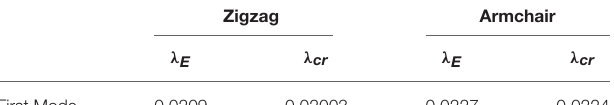
Frontiers in Materials |